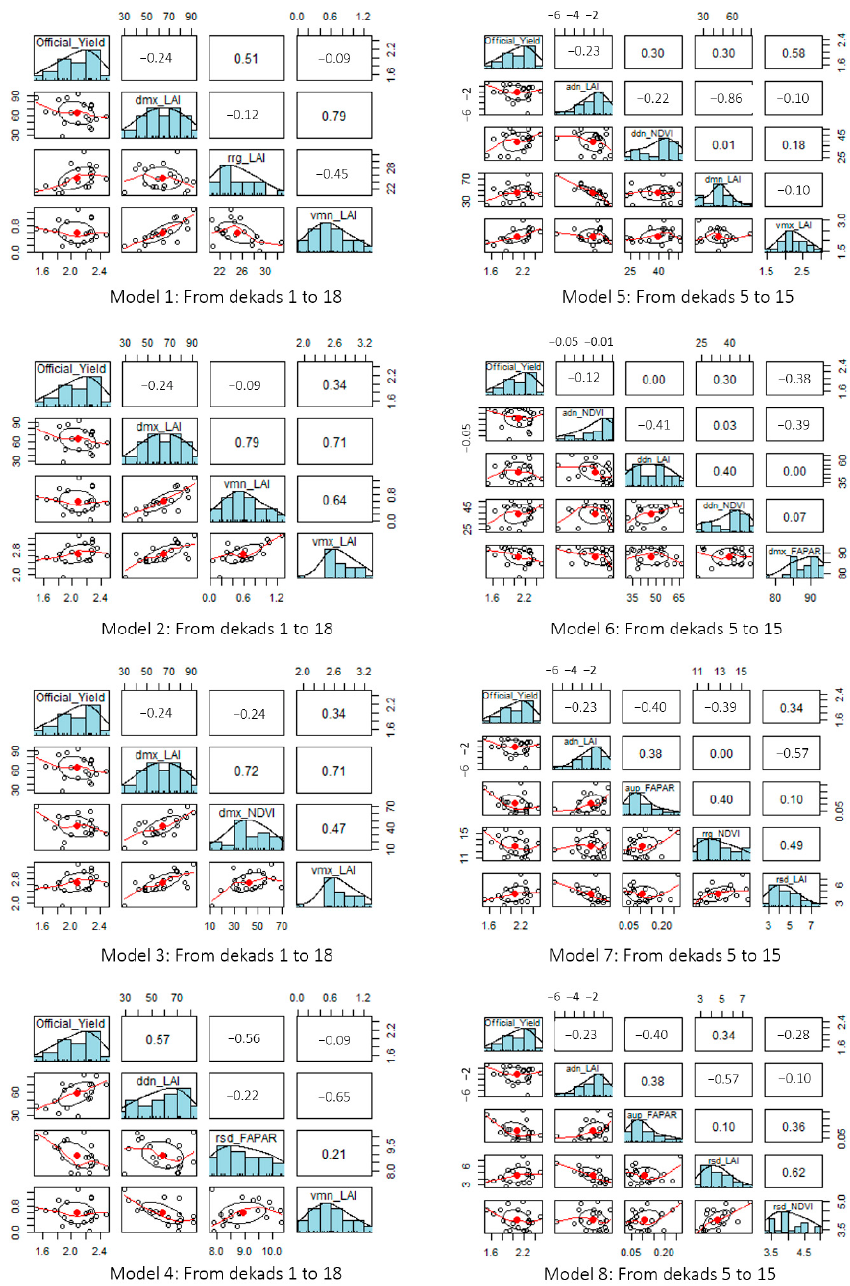
Figure 5. Correlation between the phenological variables derived from NDVI, FAPAR, and LAI for the 2000–2019 time period and selected in the eight best coffee yield models. Models 1 to 4 are based on dekads 1 to 18 (January to June), and models 5 to 8 are based on dekads 5 to 15 (mid-March to end of May). The values in the upper-right parts of the plots (above the diagonal) are the Pearson correlation coefficients between the two variables intersecting the corresponding row and column. On the diagonal is the histogram of each variable, which shows the lowest locally fit regression line. The plots below the diagonal are the bivariate scatter plots of each pair of variables. These scatter plots show an ellipse around the mean (the red point), with the axis length reflecting one standard deviation of the column and row variables. The red line is the smoothed regression lines of the bivariate scatter plots of each pair of